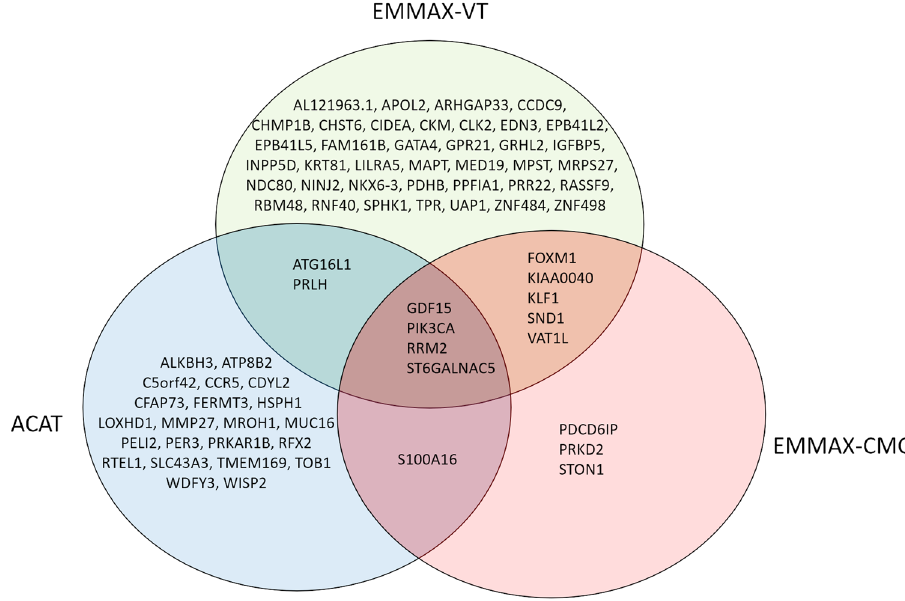
Fig. 4 Overlap between three tests in the Indo-European meta-analysis. A Venn diagram showing the overlap and unique signi fi cant genes in the Indo- European cohorts meta-analysis using the three different tests: EMMAX-VT (green), EMMAX-CMC (red), and ACAT (blue). These plots are based on results in Supplementary Data 12 –